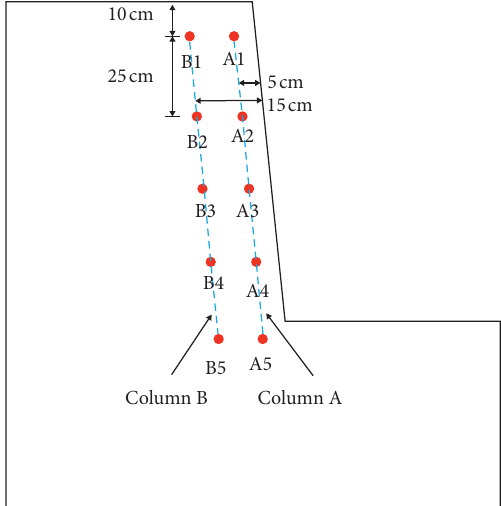
Figure 17: Displacement measuring points